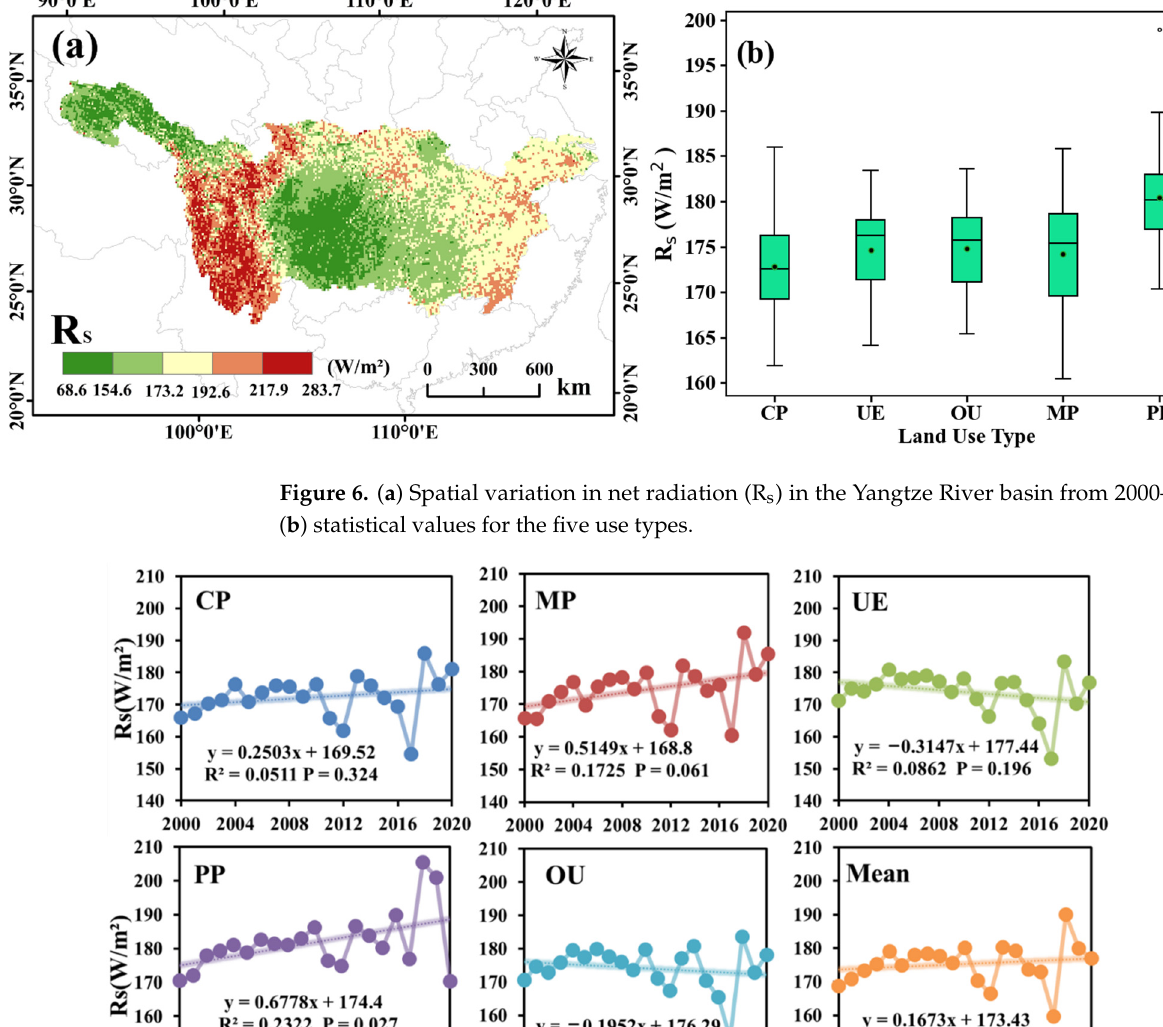
Figure 6. ( a ) Spatial variation in net radiation ( R (cid:2929) ) in the Yangtze River basin from 2000–2020 and ( b ) statistical values for the five use types.